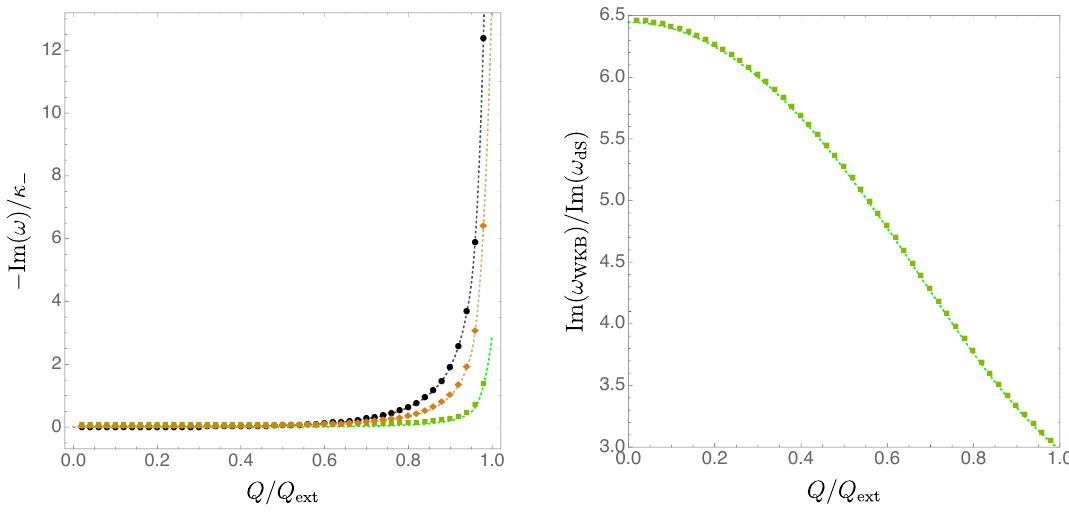
Figure 5 . Left panel: de Sitter gravitoelectromagnetic mode (cid:8) (cid:0) with ‘ = 2 and n = 0: (cid:0) Im( ! ) =(cid:20) (cid:0) as a function of Q=Q ext for (cid:12)xed y + = 0 : 01 (green squares), y + = 0 : 05 (brown diamonds) and y + = 0 : 1 (black disks). Right panel: the ratio between the frequency Im( ! dS ) of de Sitter mode of the left panel with y + = 0 : 01 and the imaginary part of the geometric optics WKB frequency prediction (5.11) for the photon sphere modes of the same black holes. We see that, for a small black hole, (cid:0) Im( ! dS ) is smaller than (cid:0) Im( ! WKB ) for the full range of Q=Q ext : .